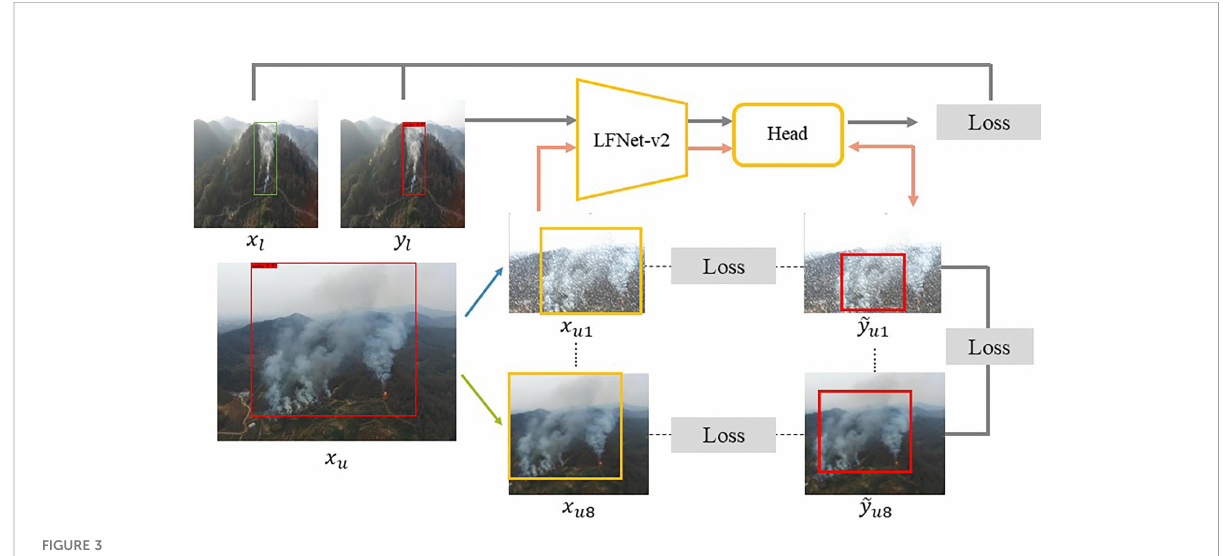
FIGURE 3 Overview of the proposed